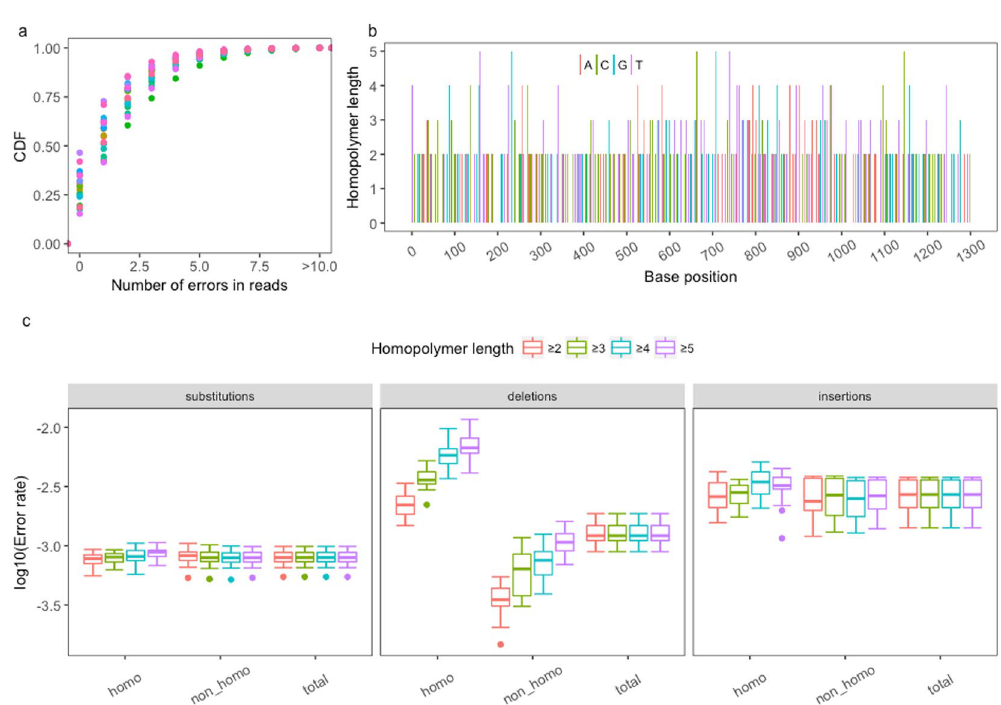
Figure 1. Error profiles of the Ion Torrent PGM data for the 19 raw samples. ( a ) Cumulative density of errors in the sequencing reads in the 19 sequencing data sets. Different colors indicate different samples. ( b ) Distribution of homopolymers with different lengths in the RT region of an HBV reference genome (AB033556). ( c ) Estimation of the error rates of insertions, deletions, and substitutions in 19 PGM data sets for the HBV-RT region grouped by regions (homopolymer, non-homopolymer and